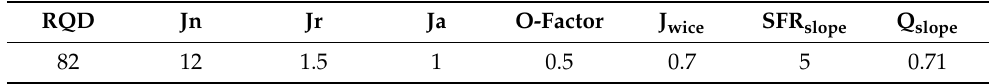
Table 4. Rock mass classification through Q-slope method.